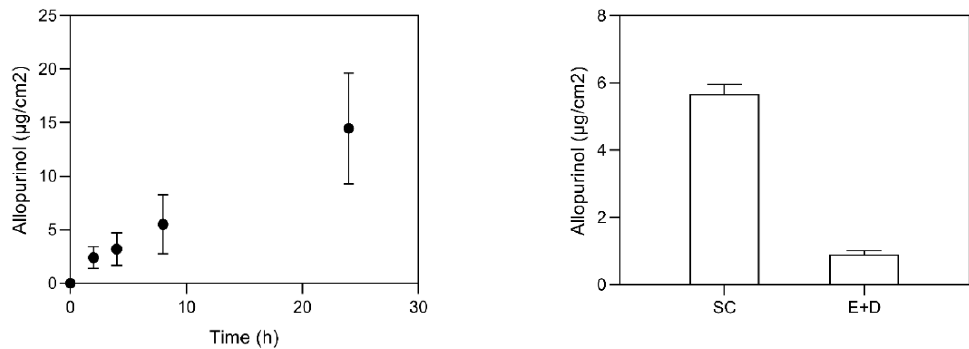
Figure 4. Permeation ( left ) and retention ( right ) assays for AP-NLC formulation. The results are expressed as mean ± S.D. ( n = 6).